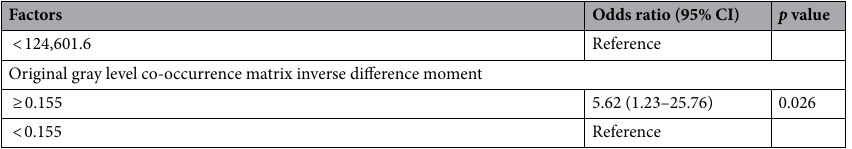
Table 5. Disease-recurrence associated imaging factors. † Weighted image. †† Apparent diffusion